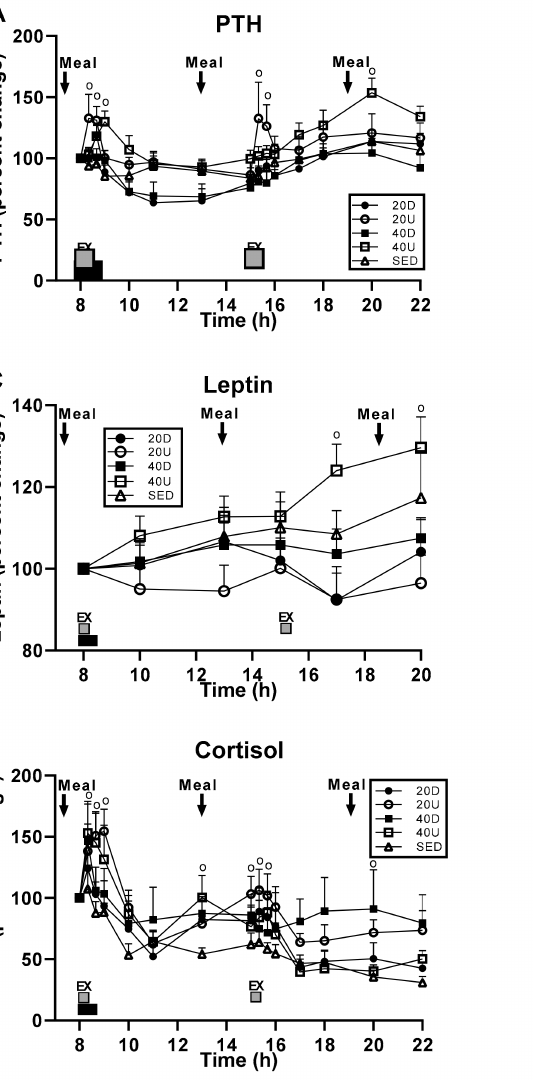
Figure 7. Effects of exercise and meals on the percent changes in hormone and in serum calcium concentrations. Treatment effect was significant only for PTH ( A ), time effects were significant for all five hormones ( A – E ), and the interaction between time and treatment for all but leptin ( A , B , D – F ). Group differences were significant at time slices marked with “o”. Total calcium concentrations in the four exercise groups were lower than in the SED group (panel F